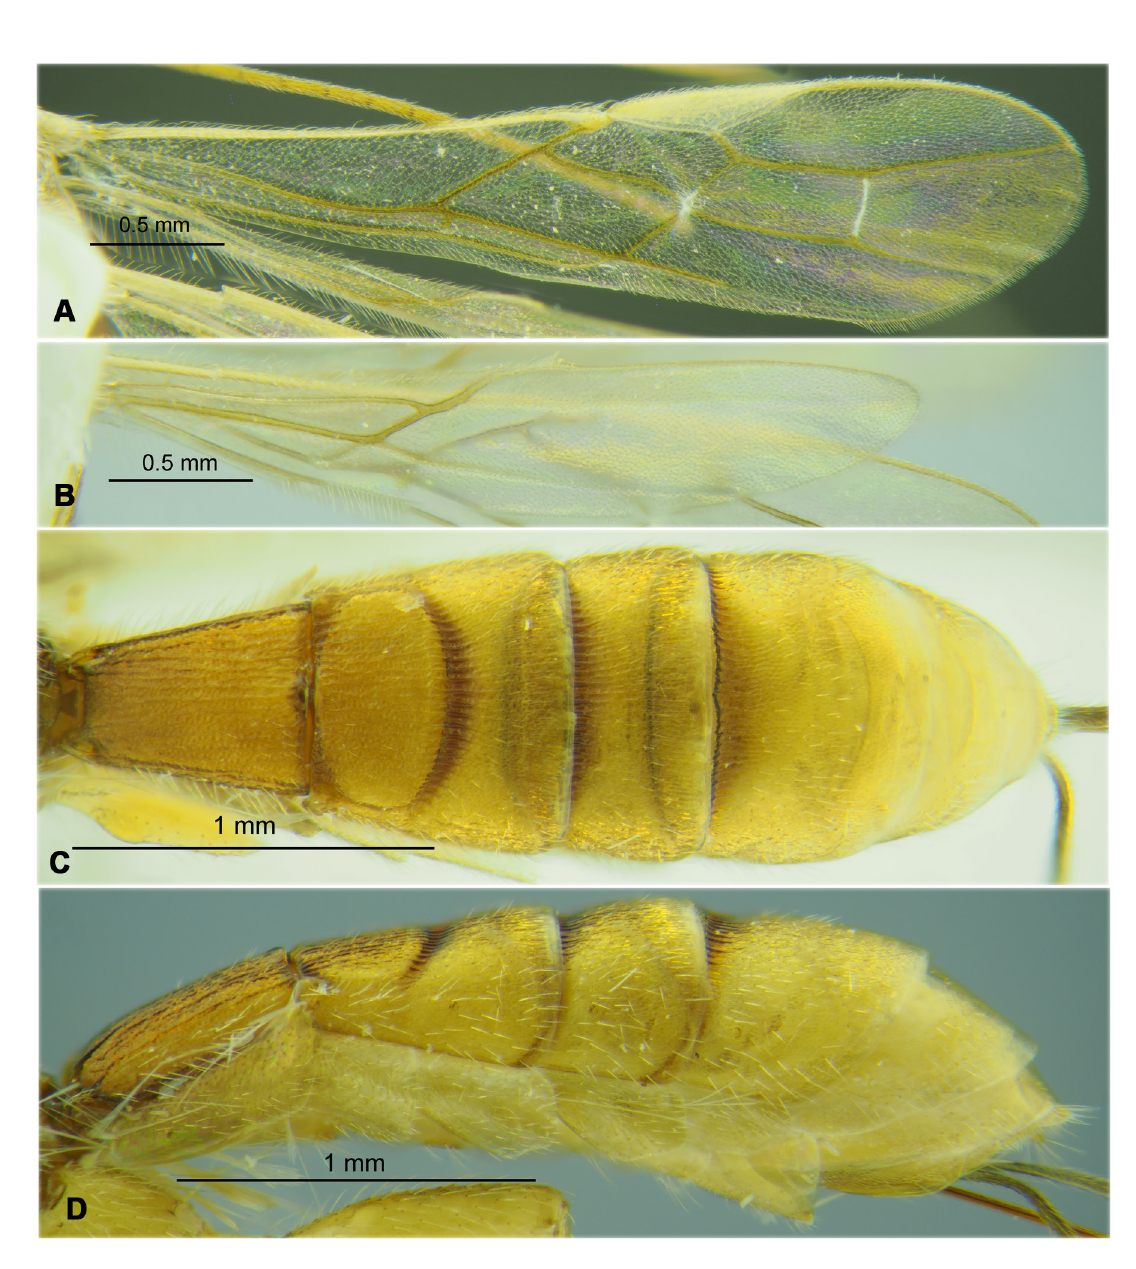
Fig. 58. Rhaconotus ( Rh. ) scirpophagae Wilkinson, 1927, ♀ (RMNH). A . Fore wing. B . Hind wing. C . Metasoma, dorsal view. D . Metasoma, lateral